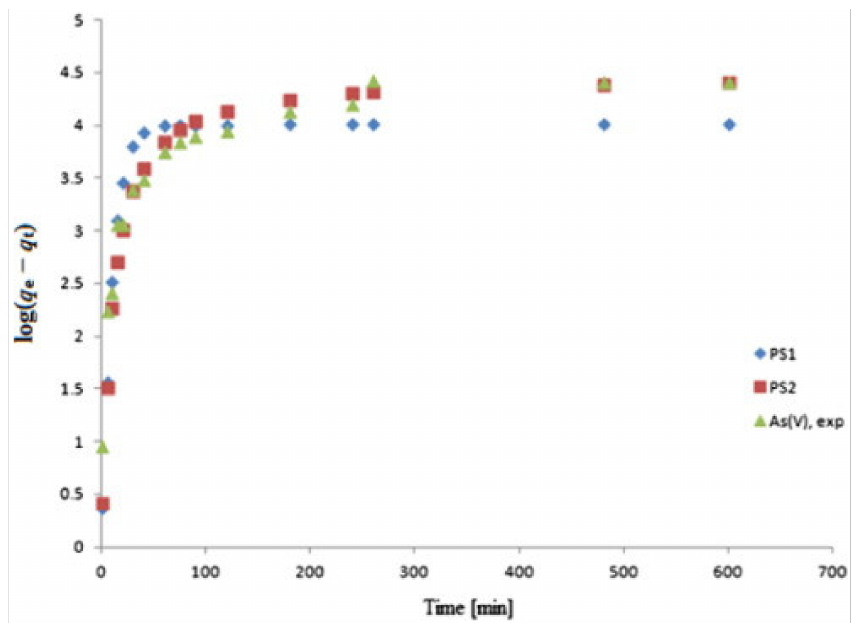
Figure 6. Illustration of the kinetic plots in relation: pseudo-first-order and pseudo-second-order models [128]. Copyrights: Elsevier,